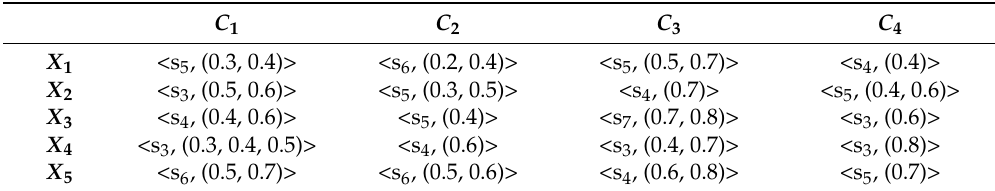
Table 17. The special linguistic hesitant fuzzy decision matrix ([67]).